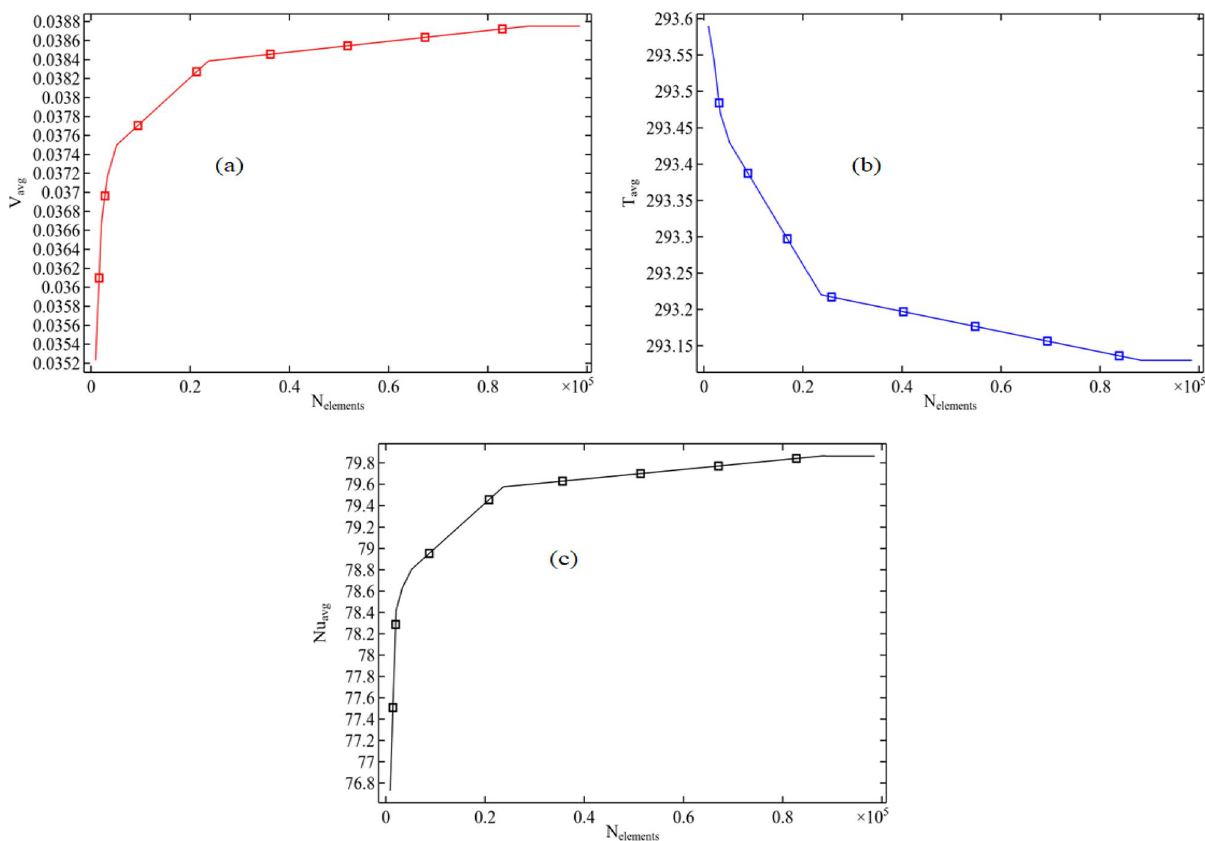
Figure 3. Mesh independent study for the numerical results calculated in the full domain for ( a ) Average velocity ( b ) Average Temperature and ( c ) Average Nusselt